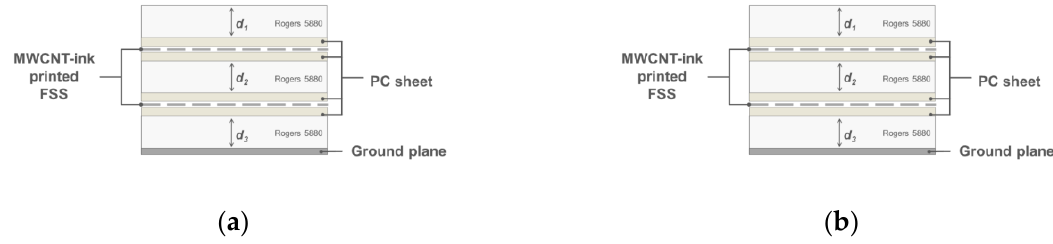
Figure 18. ( a ) cross-section ( b ) unit cell of ink-based absorber where a x = a y = 9 mm. Adapted from [27].